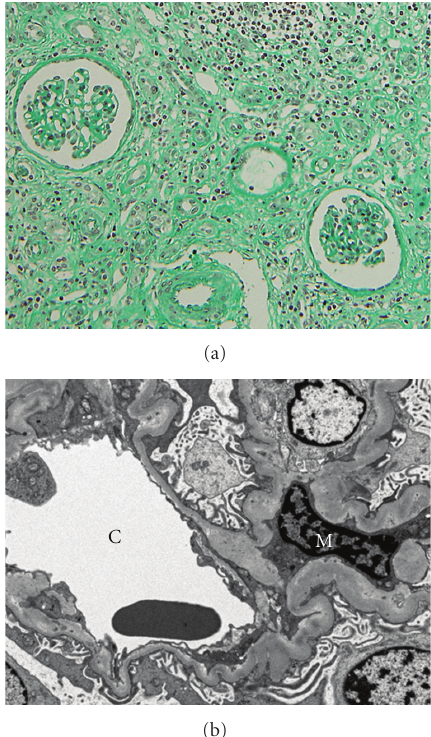
Figure 3: (a) Light microscopic photography, showing slightly ischemic change of glomerulus, tubular atrophy, mononuclear cell infiltration, and interstitial fibrosis (mathon-trichrome staining, × 200). (b) Electron micrograph of glomerulus, showing almost intact morphology without electron dense deposit. C: capillary lumen, M: mesangium.